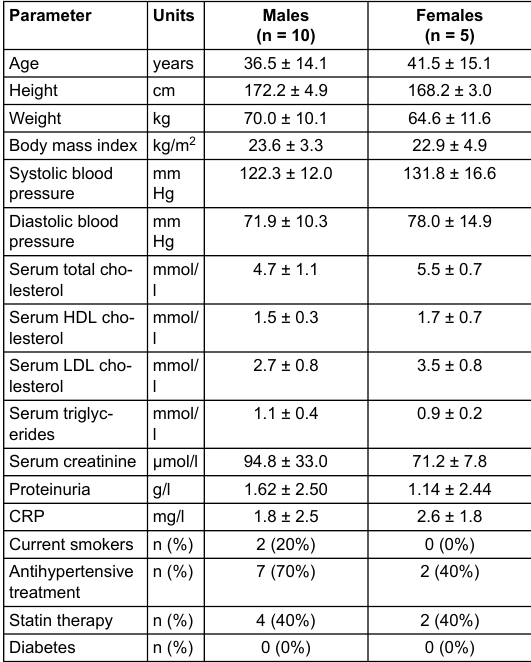
Table 1: Clinical characteristics of the male and female Fabry popula- tion at